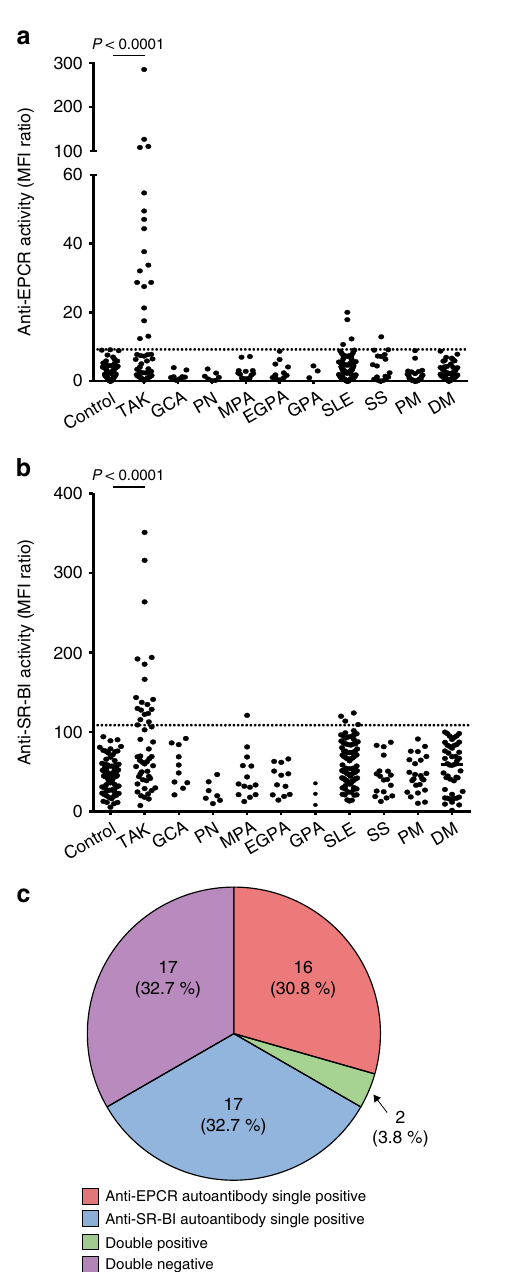
Fig. 4 Distribution of patients with anti-EPCR and anti-SR-BI activities. a , b The distribution of anti-EPCR ( a ) and anti-SR-BI ( b ) autoantibodies in healthy controls and patients with various autoimmune rheumatic diseases was measured with fl ow cytometry. Dots represent the data for individual subjects. The broken horizontal line indicates the cut-off value for high activity (mean + 3 SD). Control represents 79 healthy individuals.